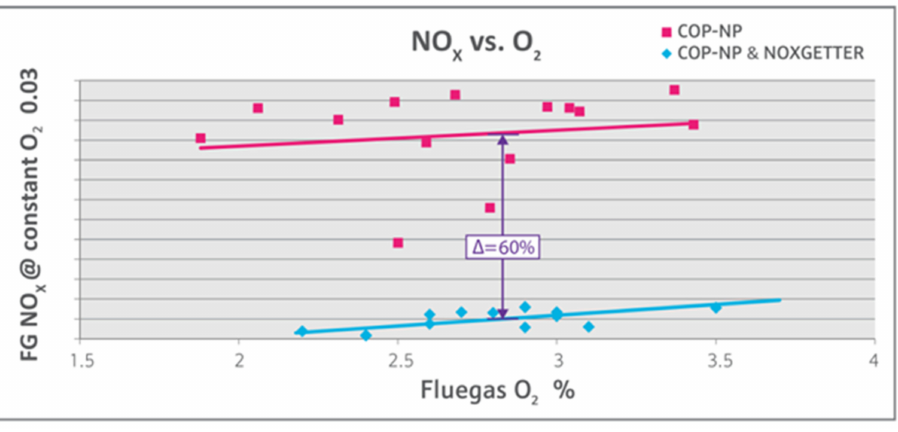
Figure 33. NOx emission against O 2 supply. Adopted from Genç et al.